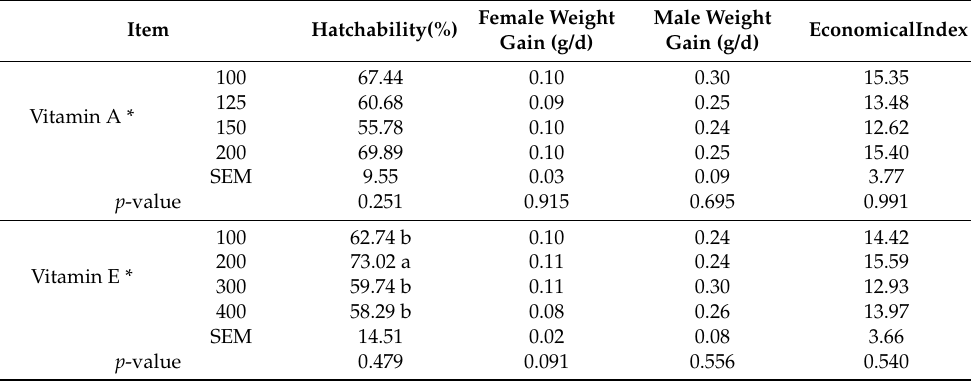
Table 5. Effect of dietary treatments on chick-related